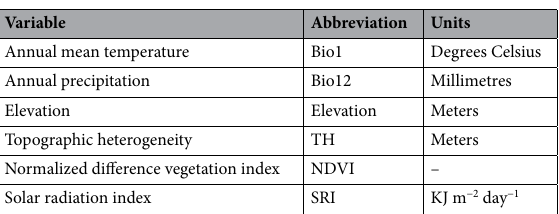
Variable Abbreviation